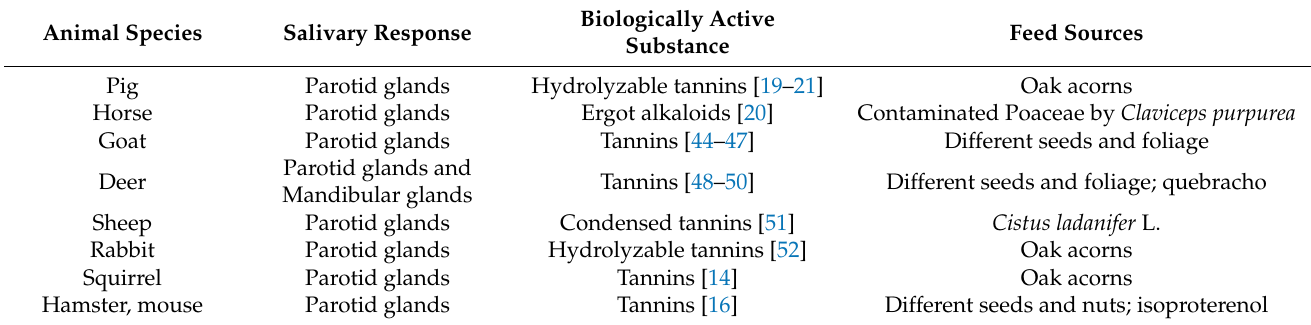
Table 2. Animal species and salivary response to biologically active substances (xenobiotics) potentially present in the natural